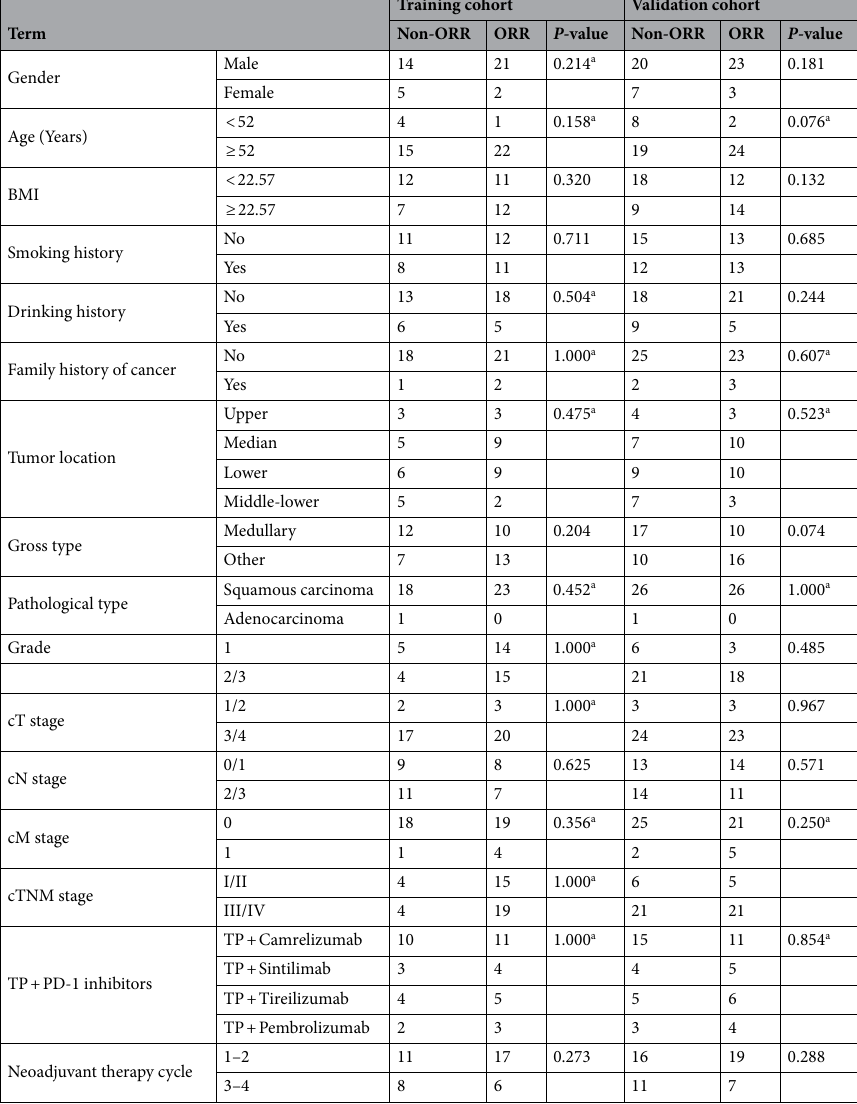
Table 1. Characteristics of esophageal cancer patients received neoadjuvant chemotherapy combined with immunotherapy. ORR, objective response rate; BMI, body mass index; PD-1, programmed cell death protein-1; TP, taxol +